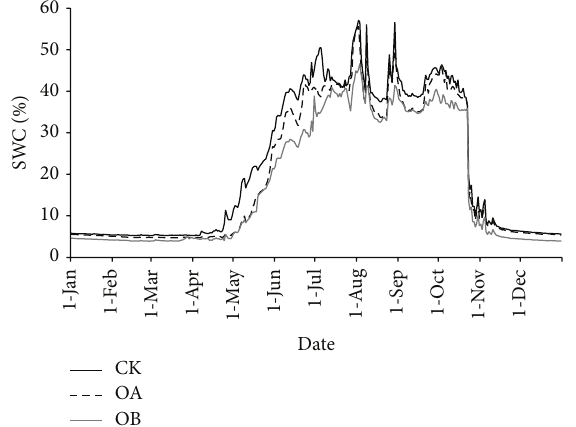
Figure 3: Seasonal variations in 5cm depth soil water content corresponding to the warming treatments.